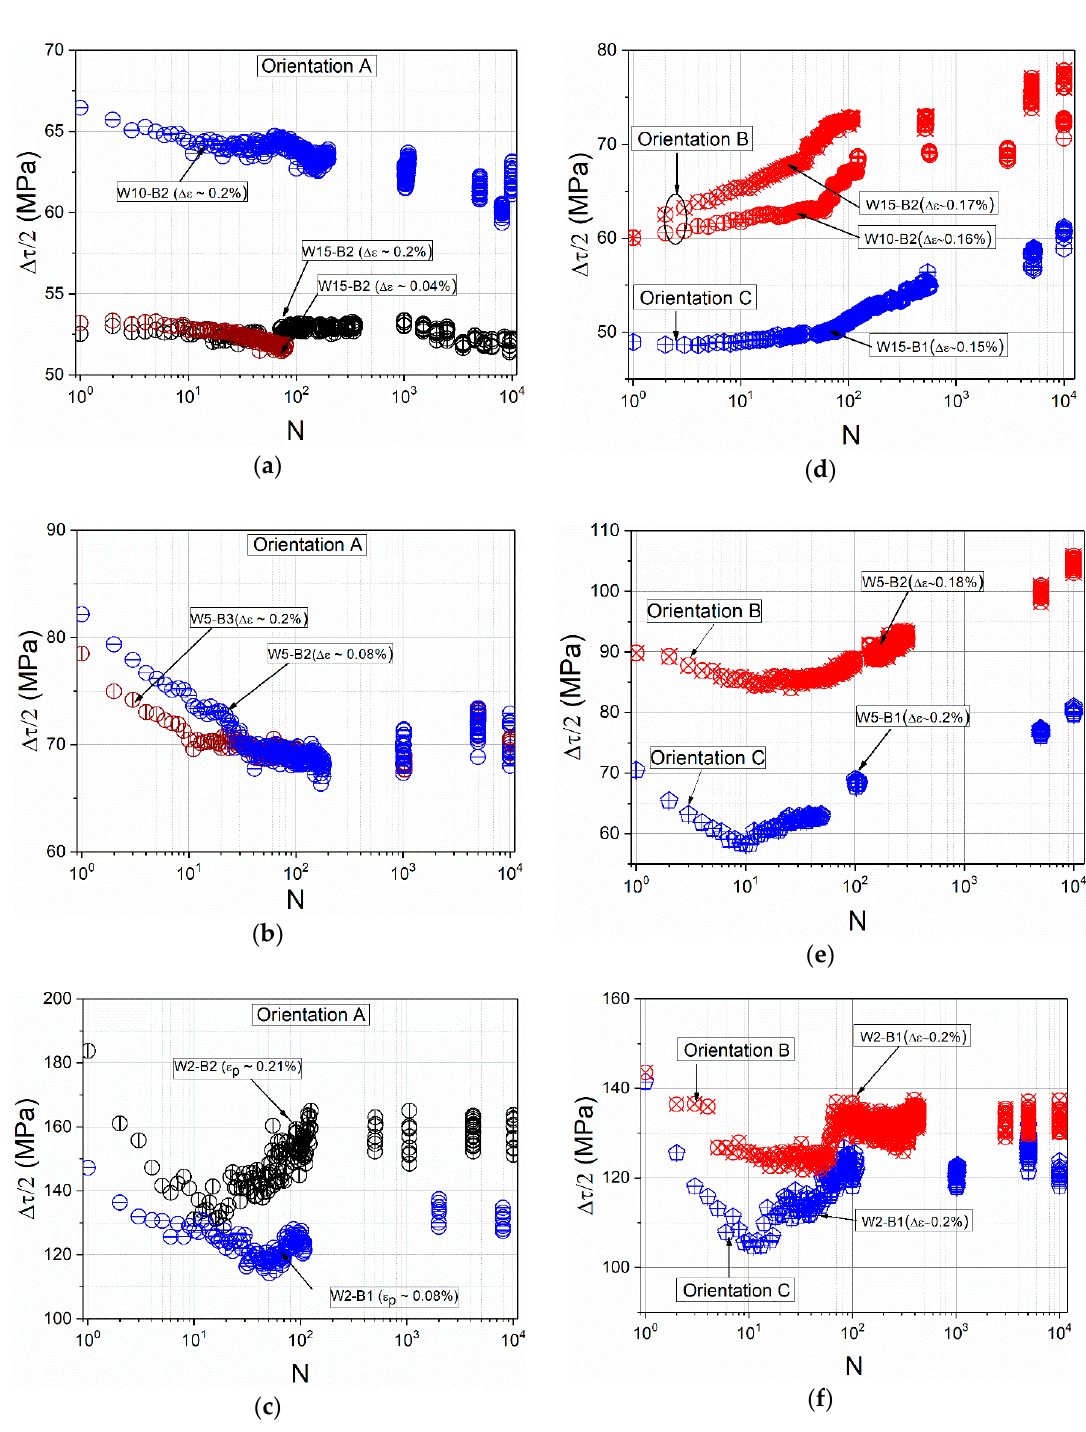
Figure 3. Cyclic stress curves of beams with the orientation A, B, and C: In ( a – c ) are results of the larger (15 and 10 µm), medium (5 µm), and smaller (2 µm) beams, respectively, with the A orientation and in ( d – f ) the results of the larger, medium, and smaller beams, respectively, with the B and C orientation.